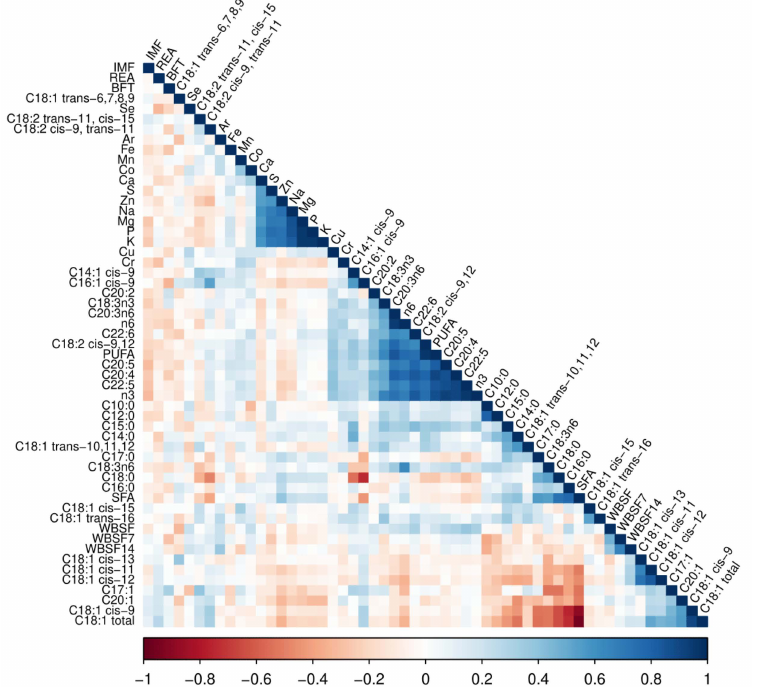
Figure 1. Correlogram of mineral and fatty acid content phenotypes, carcass and meat quality traits. Red squares represent negative correlations, blue squares represent positive correlations and the white squares represent phenotypes without correlation in this